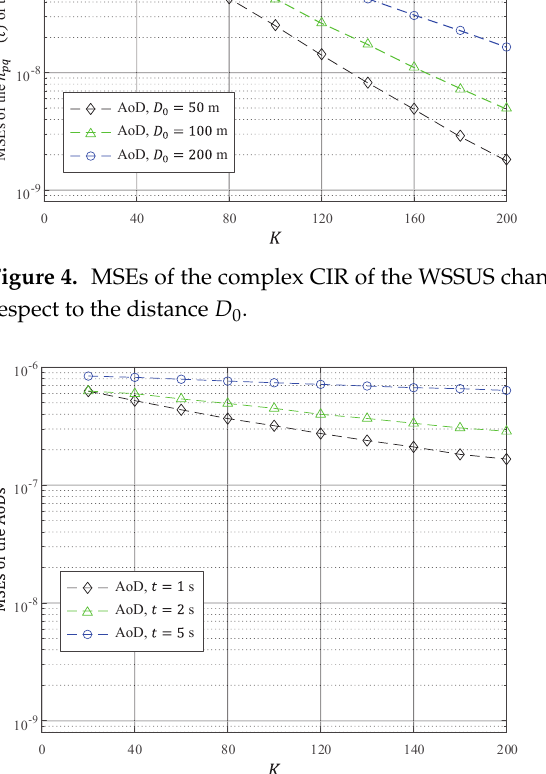
Figure 5. MSEs of the AoD estimations in the non-WSSUS channel models for V2V communications with respect to the distance D 0 when v T = 10 m/s, v R = 10 m/s, ϕ T = π , and ϕ R = 0.